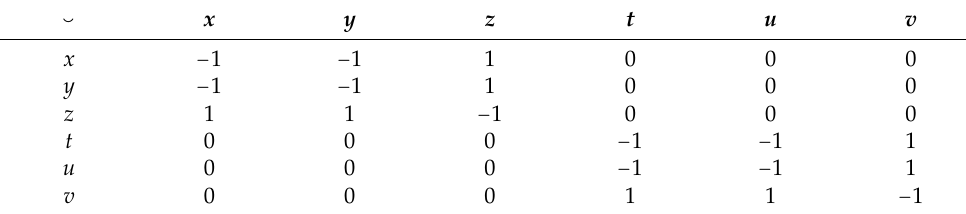
Table A1. Cup product of the cocycles deduced from Figure A7.